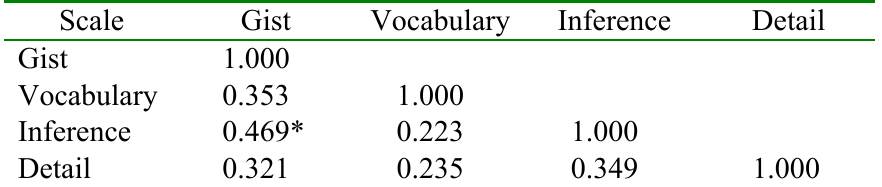
Correlation Matrix between Variables for the Reading Test ( K =9, N =29) Scale Gist Vocabulary Inference